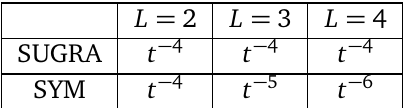
Table 1: Scaling behavior of the N = 8 SUGRA and N = 4 SYM multi-particle unitar- ity cuts under the deformation defined by Eqs. (14) and (16) for the